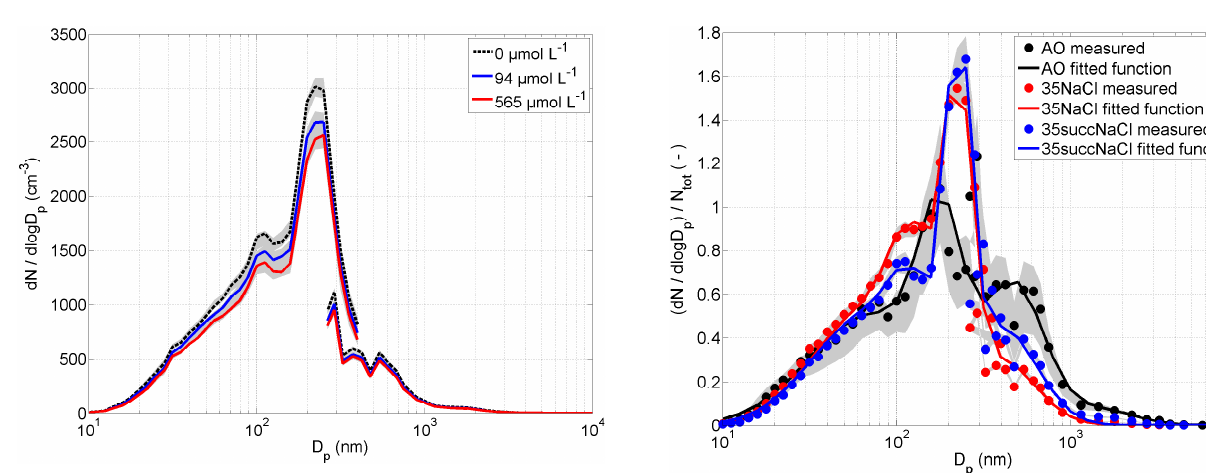
Fig. 9. Comparison between the normalized fitted particle num- ber size distribution of Arctic Ocean water (water temperature me- dian − 0.3 ◦ C, salinity median 35.0gkg − 1 , RH mean = 7%), sodium chloride water without succinic acid (water temperature median is 0.1 ◦ C and median salinity is 35.3gkg − 1 , RH mean = 29%) and sodium chloride water with succinic acid (water temperature me- dian is − 0.1 ◦ C and median salinity is 35.6gkg − 1 , RH mean = 23%). The normalized size distributions measured and the 25th and 75th percentiles (grey shaded areas) are shown in